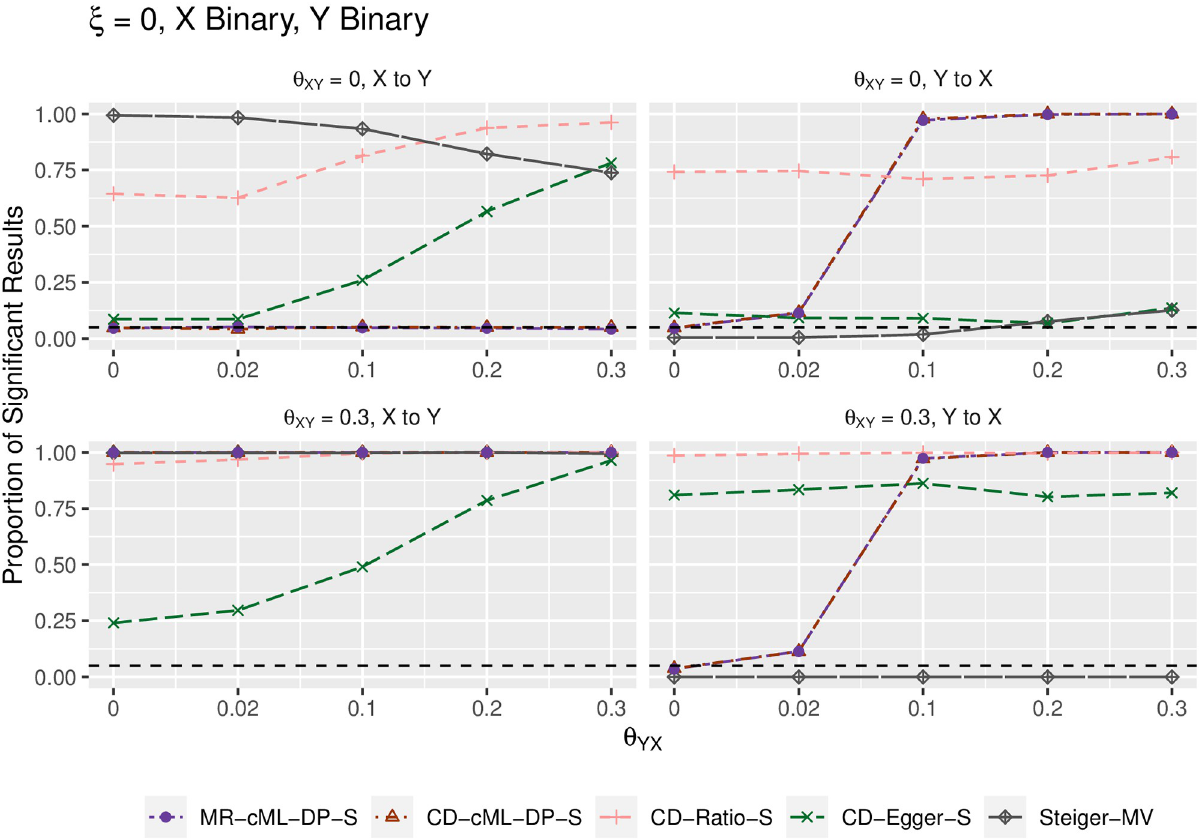
Fig 3. Empirical type-I error and power (y-axis) for both X and Y binary, ξ = 0 (i.e. no correlated pleiotropy), θ XY = 0 (top panels) and θ XY = 0.3 (bottom) for various values of θ (x-axis). The left panels show results for the direction X ! Y , the right ones show results for the direction Y ! X . YX